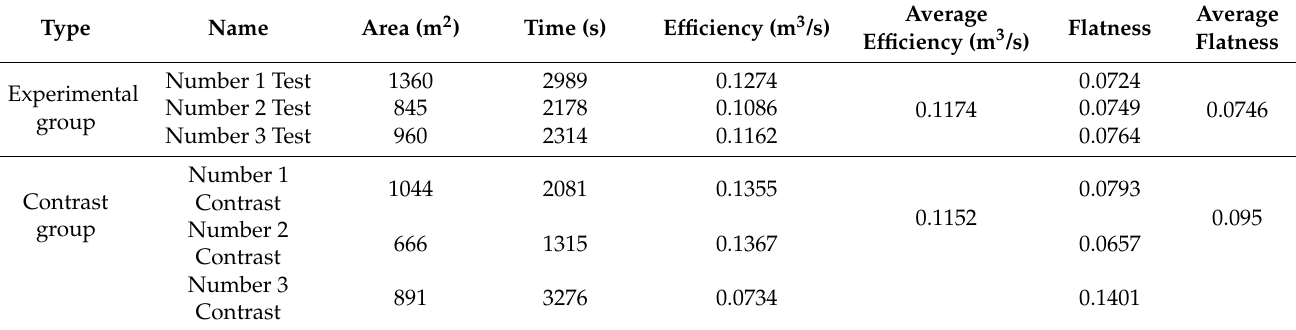
Table 1. Experimental